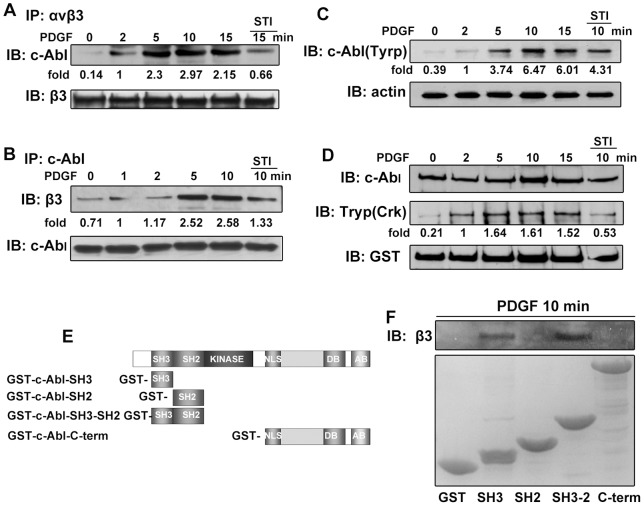
c-Abl kinase activity is required for the interaction of c-Abl and αvβ3 integrin.(A and B) Overnight serum starved A375 cells were trypsinized, washed with PBS and untreated or treated with 20 ng/ml PDGF for the indicated times. Thereafter, the cells were lysed, and the lysates were immunoprecipitated with indicated antibodies and subjected to immunoblotting analysis with the appropriate antibodies. For inhibition assay, cells were pretreated with STI571 for 10 min and the inhibitor remained in the medium throughout the assay. (C) A375 cells were serum-starved and stimulated with PDGF for the indicated times. The lysates of cells were immunoblotted, and the activity of c-Abl tyrosine kinase was tested by immunoblotting with PY20. The loading control was immunoblotted with anti-actin antibody. (D) A375 cells were serum-starved and stimulated with PDGF for the indicated times. The activity of c-Abl kinase was determined by using an in vitro kinase assay with GST-CrkII-CTD as a substrate. Phosphorylation of GST-CrkII-CTD was tested by immunoblotting with PY20 (p-Tyr Antibody). The level of GST-CrkII-CTD was detected with anti-GST antibody to demonstrate equal loading. (E) A schematic diagram of GST c-Abl domains. (F) A375 cells were serum-starved and stimulated with PDGF for 10 minutes. The GST c-Abl domain pull-down assay was done, and the bound proteins were analyzed by SDS-PAGE and immunoblotted for β3 integrin. The immunoblotting bands were quantified by densitometry, and the data were normalized with respect to the controls.